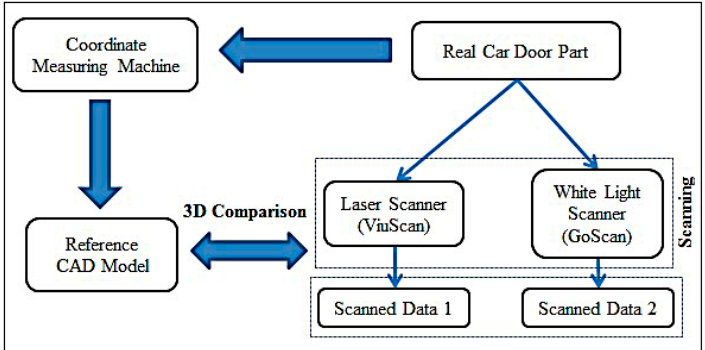
Figure 5. Methodology adopted to compute the accuracy of two scanners. CAD: Computer-Aided Design . A medium-size bridge-type CMM (Accura, Zeiss, Oberkochen, Germany) with an accuracy of (1.6 + L/333) μ m, which complied with DIN EN ISO 10360-2:2001, was employed in this investigation